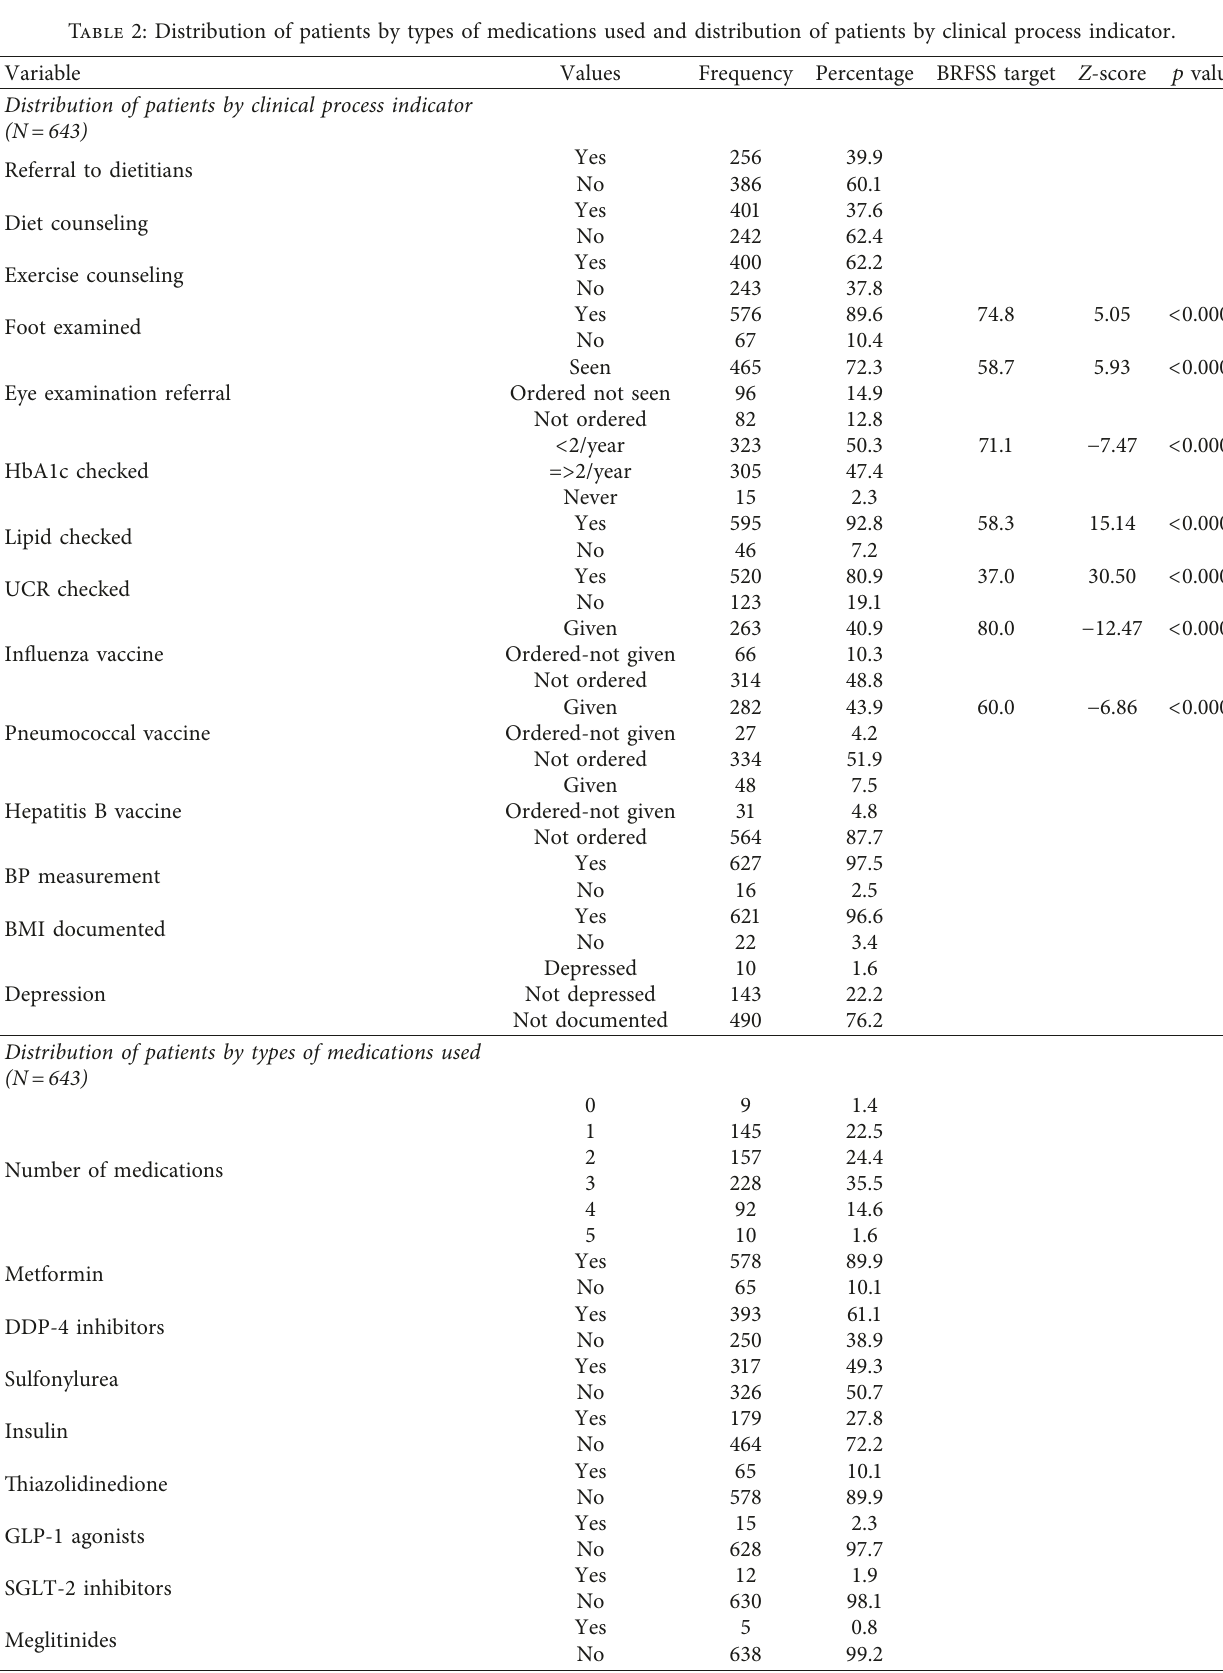
Table 2: Distribution of patients by types of medications used and distribution of patients by clinical process indicator.